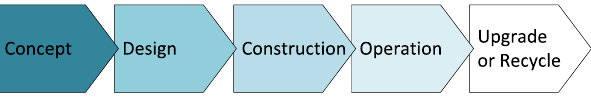
FIG. 2. System life cycle